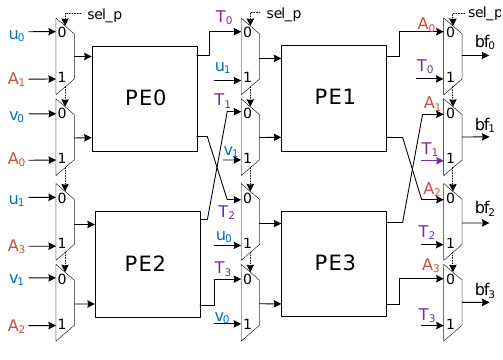
Figure 10: The routing structure of radix-4 PE